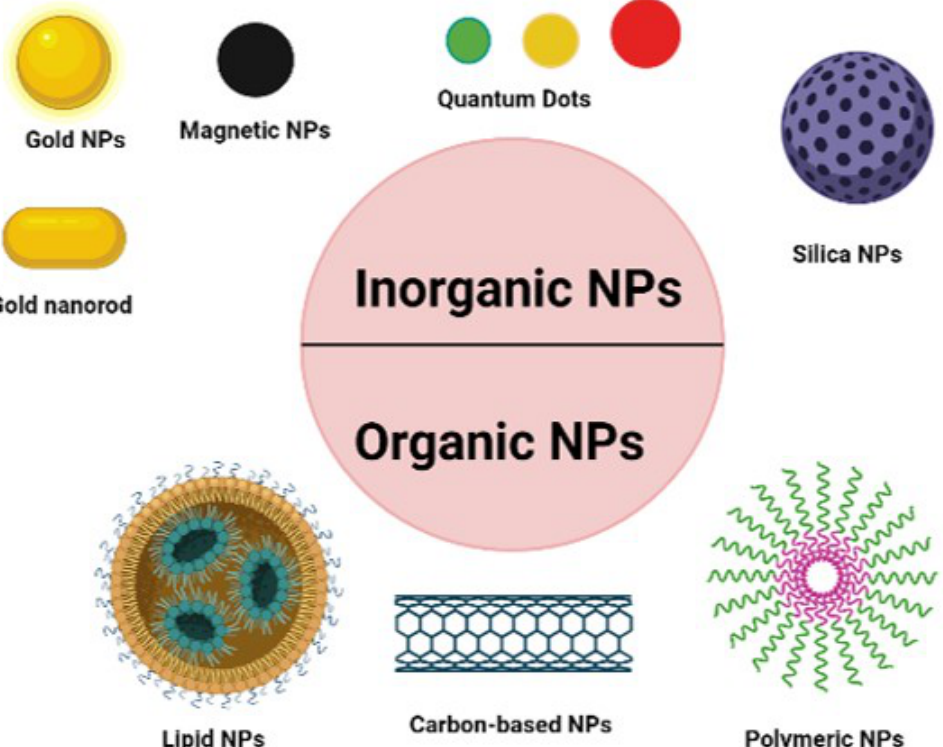
Scheme 1. Types of nanomaterials used for diagnosis and therapeutics of